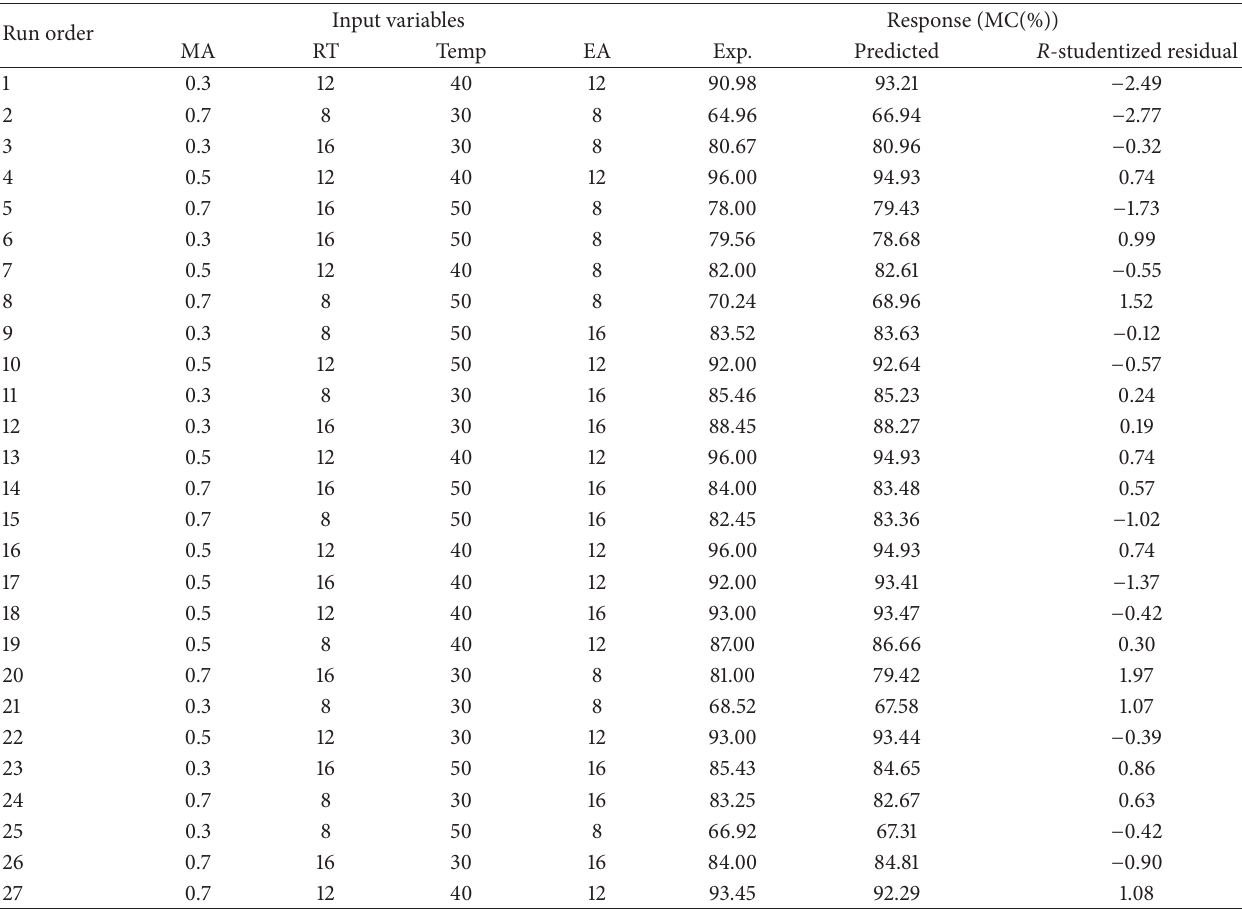
Table 2: Central composite design with the experimental, predicted responses and its 𝑅 -studentized residuals.